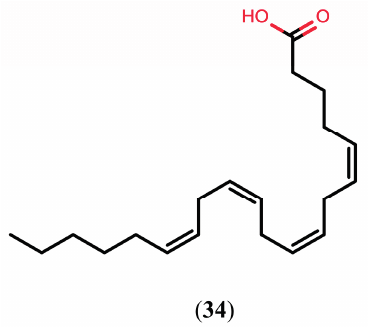
Figure 7. Chemical structure of arachidonic